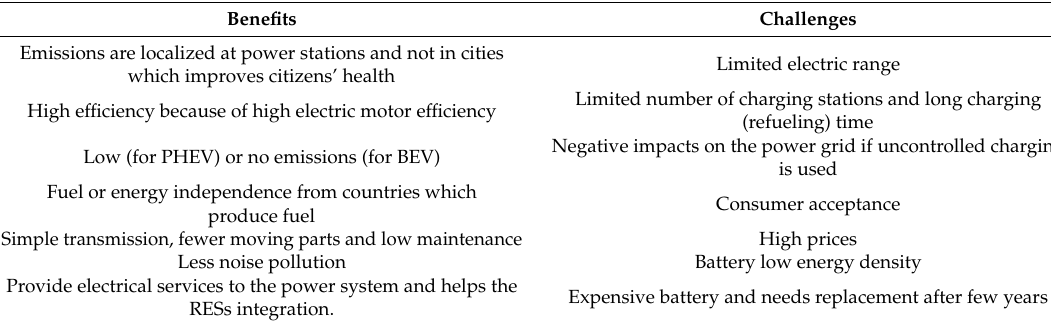
Table 2. Benefits and challenges of EVs.